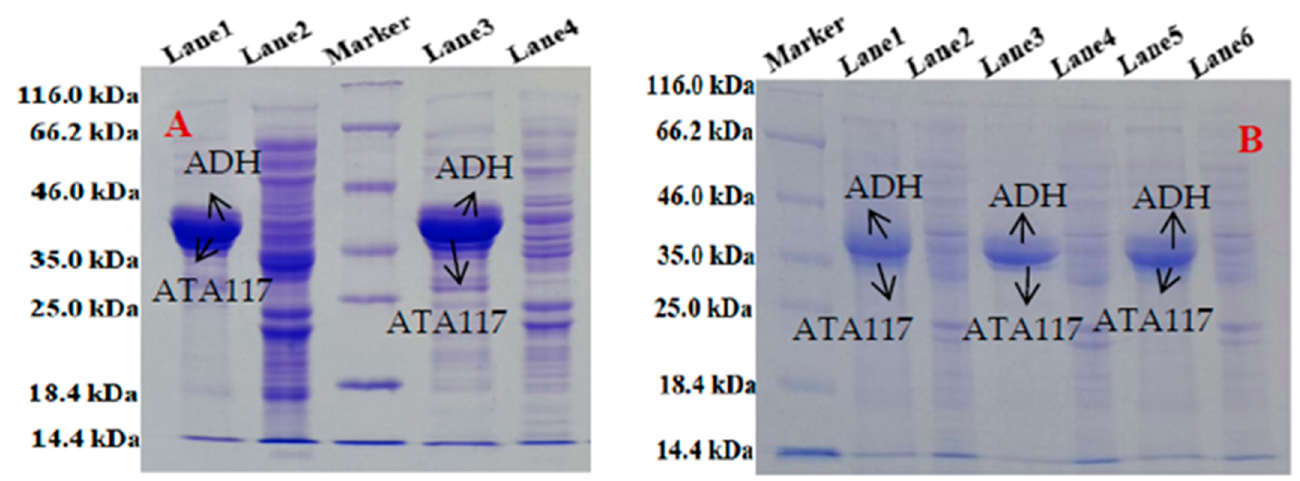
Figure 5. The protein expression of ATA117/ADH by the two tandemly expressing recombinant engineered bacteria ( A ) and three double-plasmid engineered bacteria ( B ). ( A ): Lane 1: Supernatant